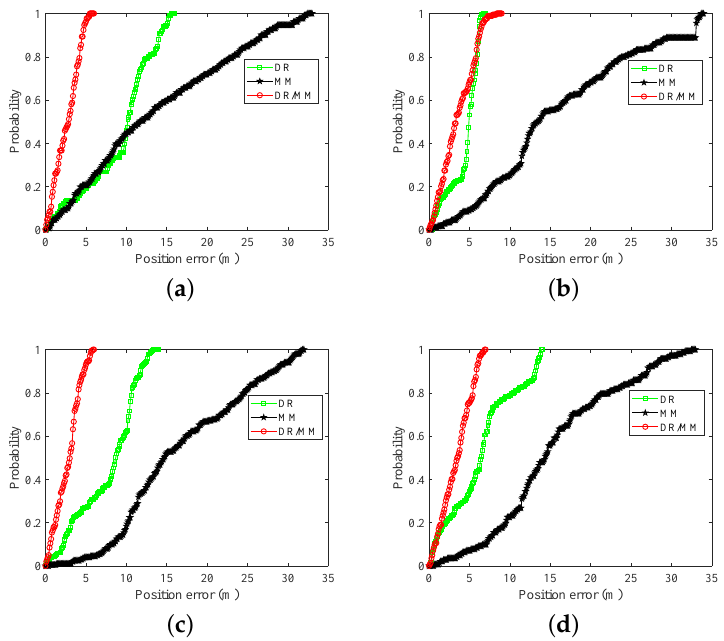
Figure 8. CDFs with different gestures in teaching building: ( a ) calling; ( b ) dangling; ( c ) handheld; and ( d )